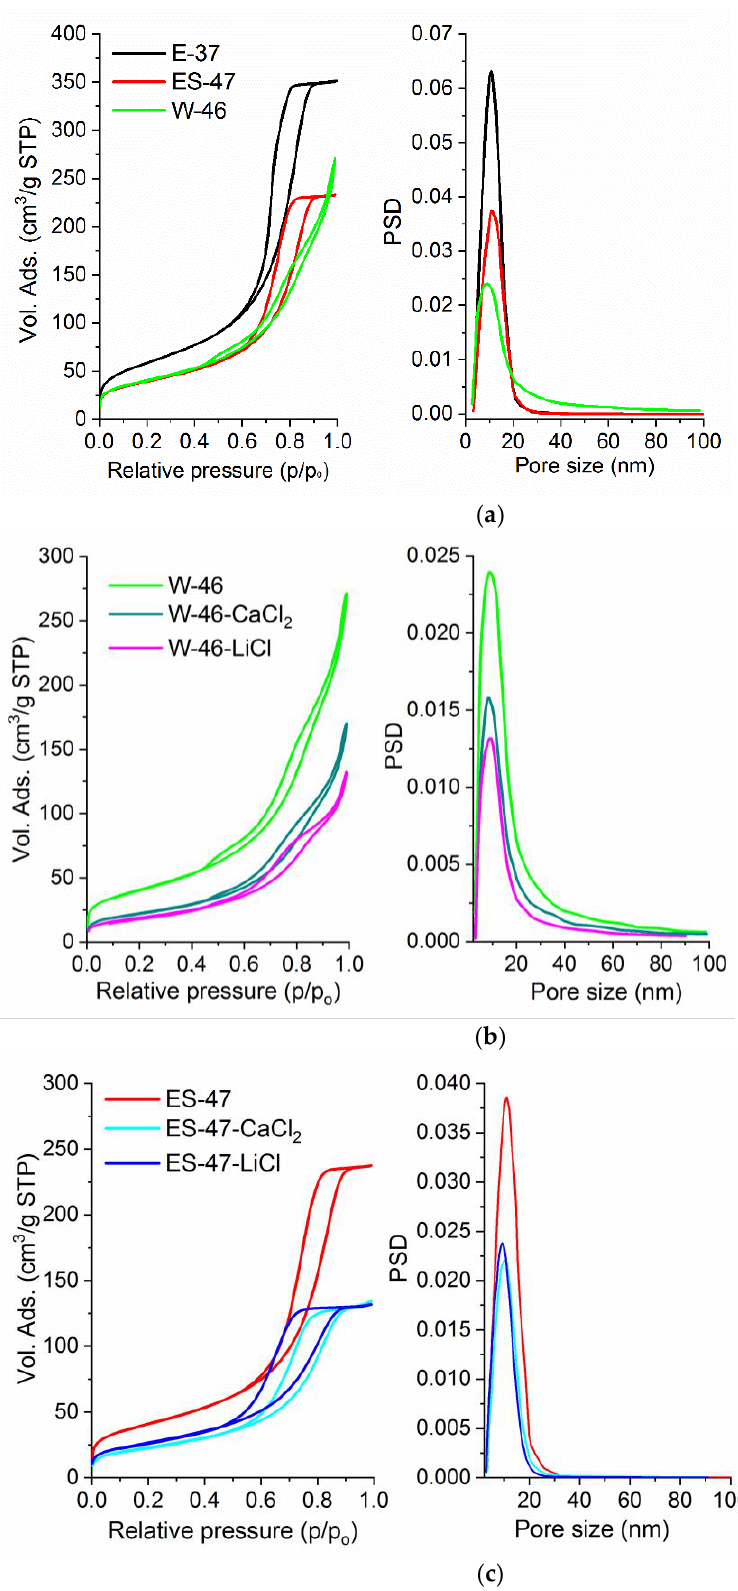
Figure 4. Nitrogen sorption isotherms of ( a ) γ -alumina supports with corresponding PSDs, ( b ) W-46 and its composites with corresponding PSDs, ( c ) ES-47 and its composites with corresponding PSDs.